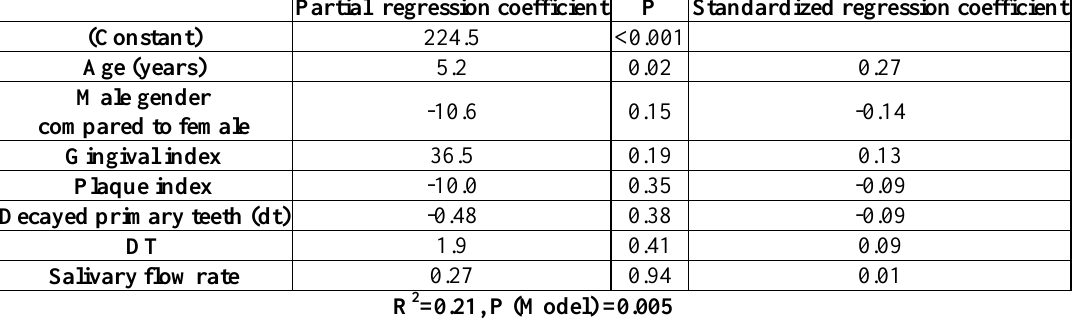
Table 3: Multiple linear regression model with salivary amylase concentration as the dependent (response) variable and selected independent variables